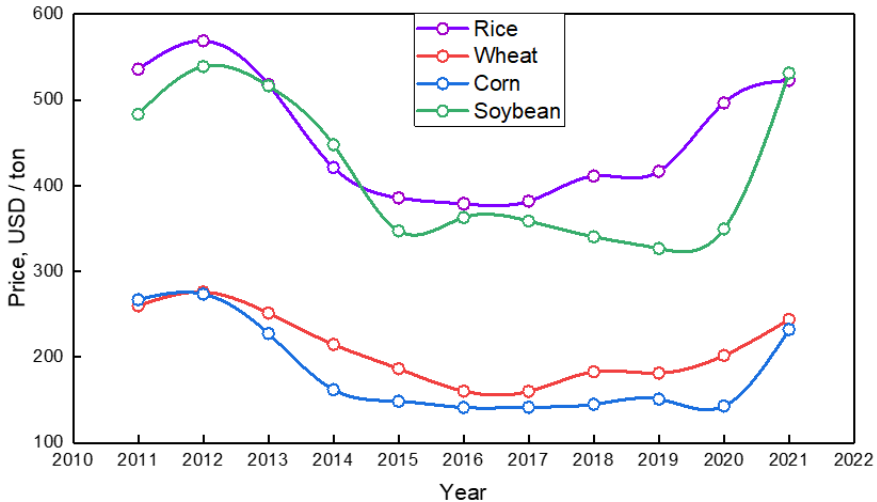
Figure 6. International grain prices, 2011–2021 (Ministry of Agriculture and Rural Affairs of the People’s Republic of China).